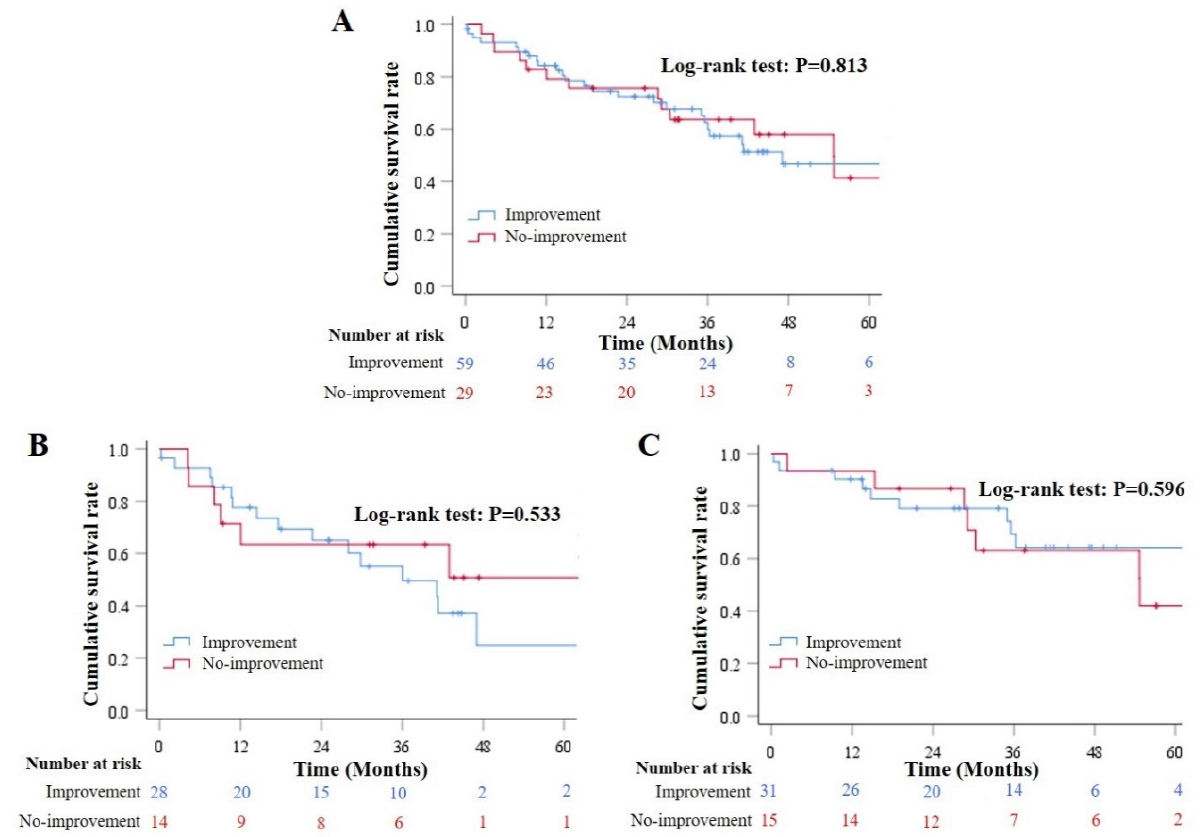
Figure 4. Long-term survival according to the improvement of hyponatremia during hospitalizations. ( Panel A ): Kaplan–Meier curves showed the cumulative survival rates in overall patients who had and did not have improvement of hyponatremia during hospitalizations. ( Panel B ): Kaplan–Meier curves showed the cumulative survival rates in overall patients who had and did not have improvement of hyponatremia during hospitalizations in the HA group. ( Panel C ): Kaplan–Meier curves showed the cumulative survival rates in overall patients who had and did not have improvement of hyponatremia during hospitalizations in the control